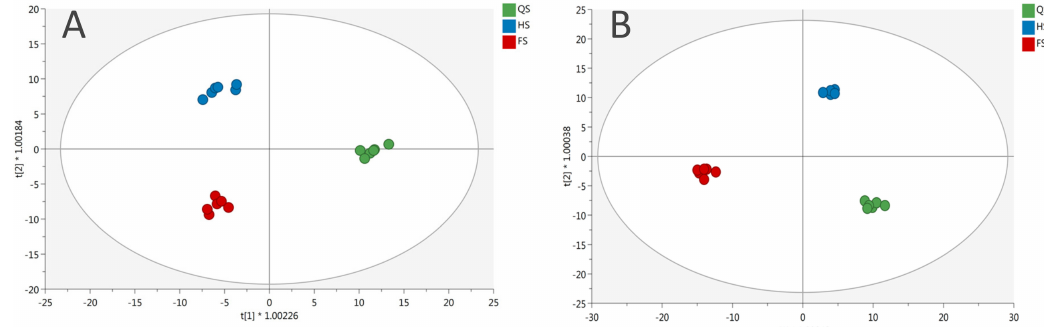
Figure 1. Orthogonal projection to latent structures discriminant analysis ( OPLS-DA) built using ( A ) green and ( B ) red Salanova samples grown at reduced nutrient concentrations (full strength (FS), half strength (HS), and quarter strength